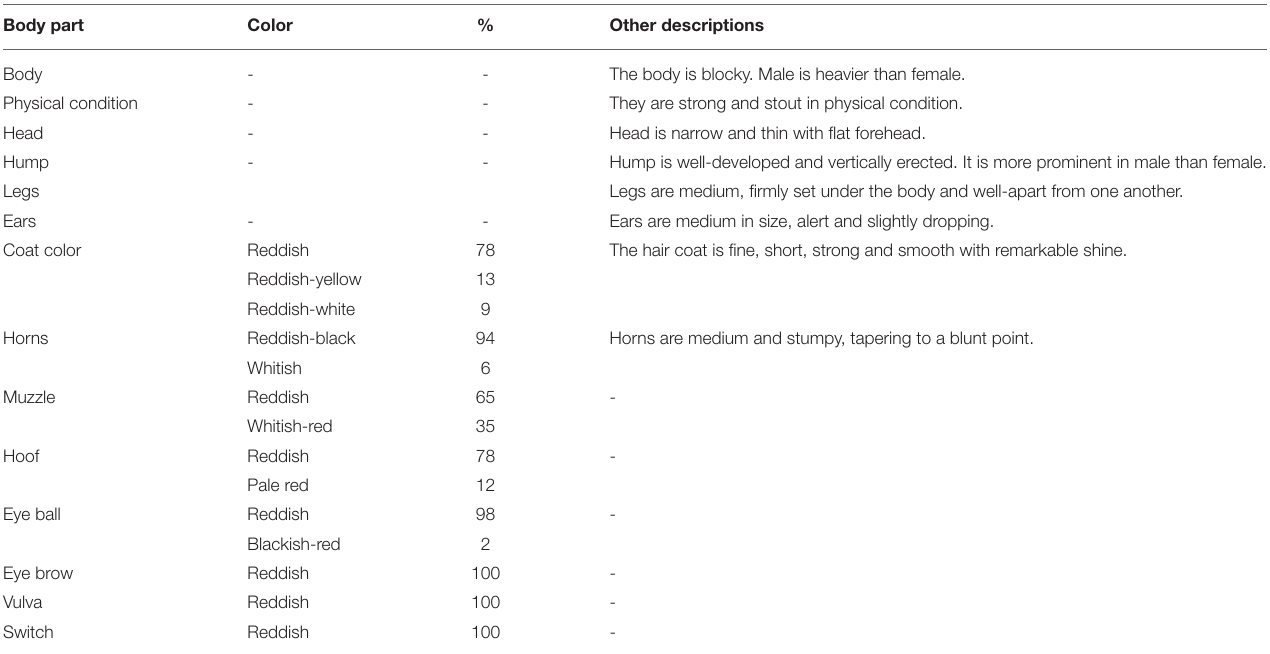
TABLE 3 | Physical appearance of Red Chittagong cattle. Body part